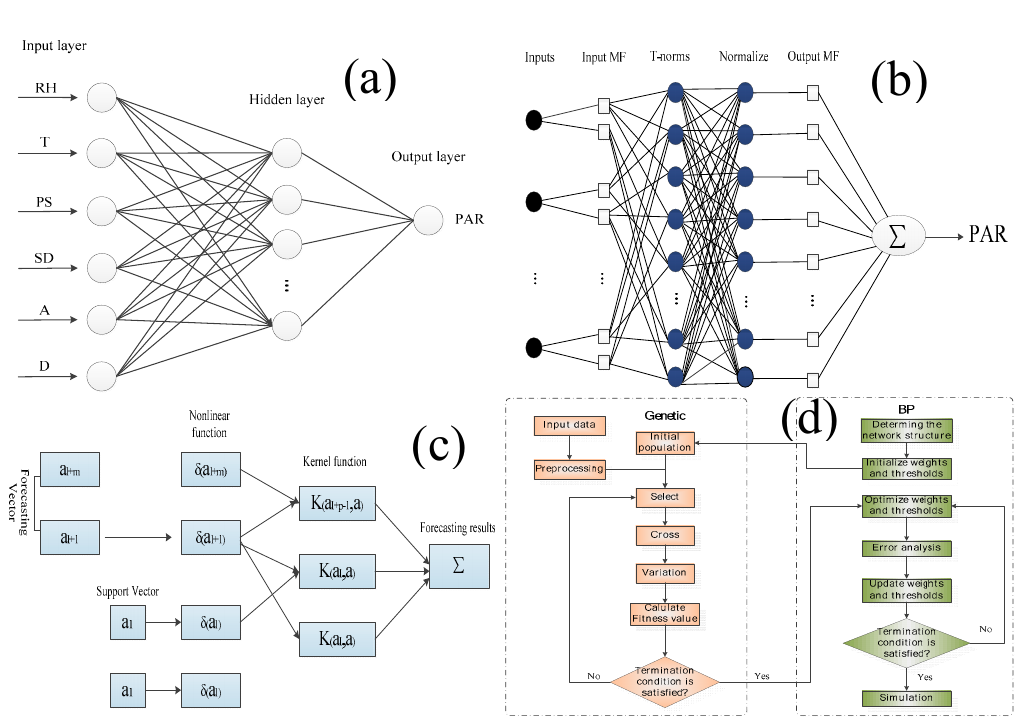
Figure 3. The general structures of the back propagation (BP) network, the adaptive neuro fuzzy inference system (ANFIS), the least squares support vector machine (LSSVM), and the Genetic algorithm model; ( a ) BP, ( b ) ANFIS, ( c ) LSSVM, and ( d ) Genetic.